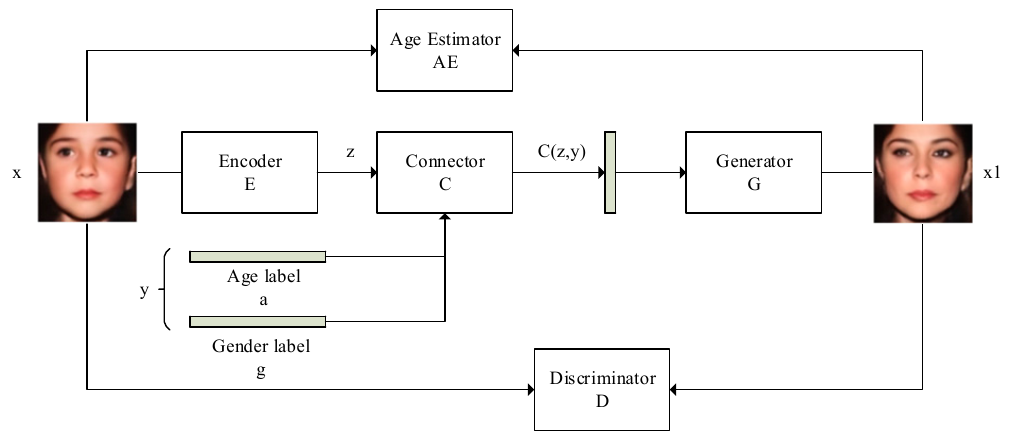
Figure 2. The framework of our method.